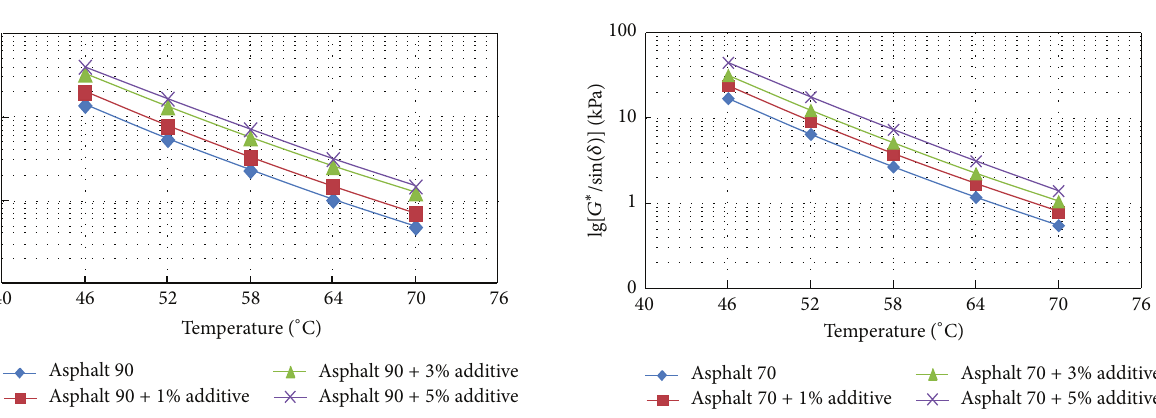
Figure 5: Rutting factors of 70# virgin asphalt and WMA binder versus temperature.